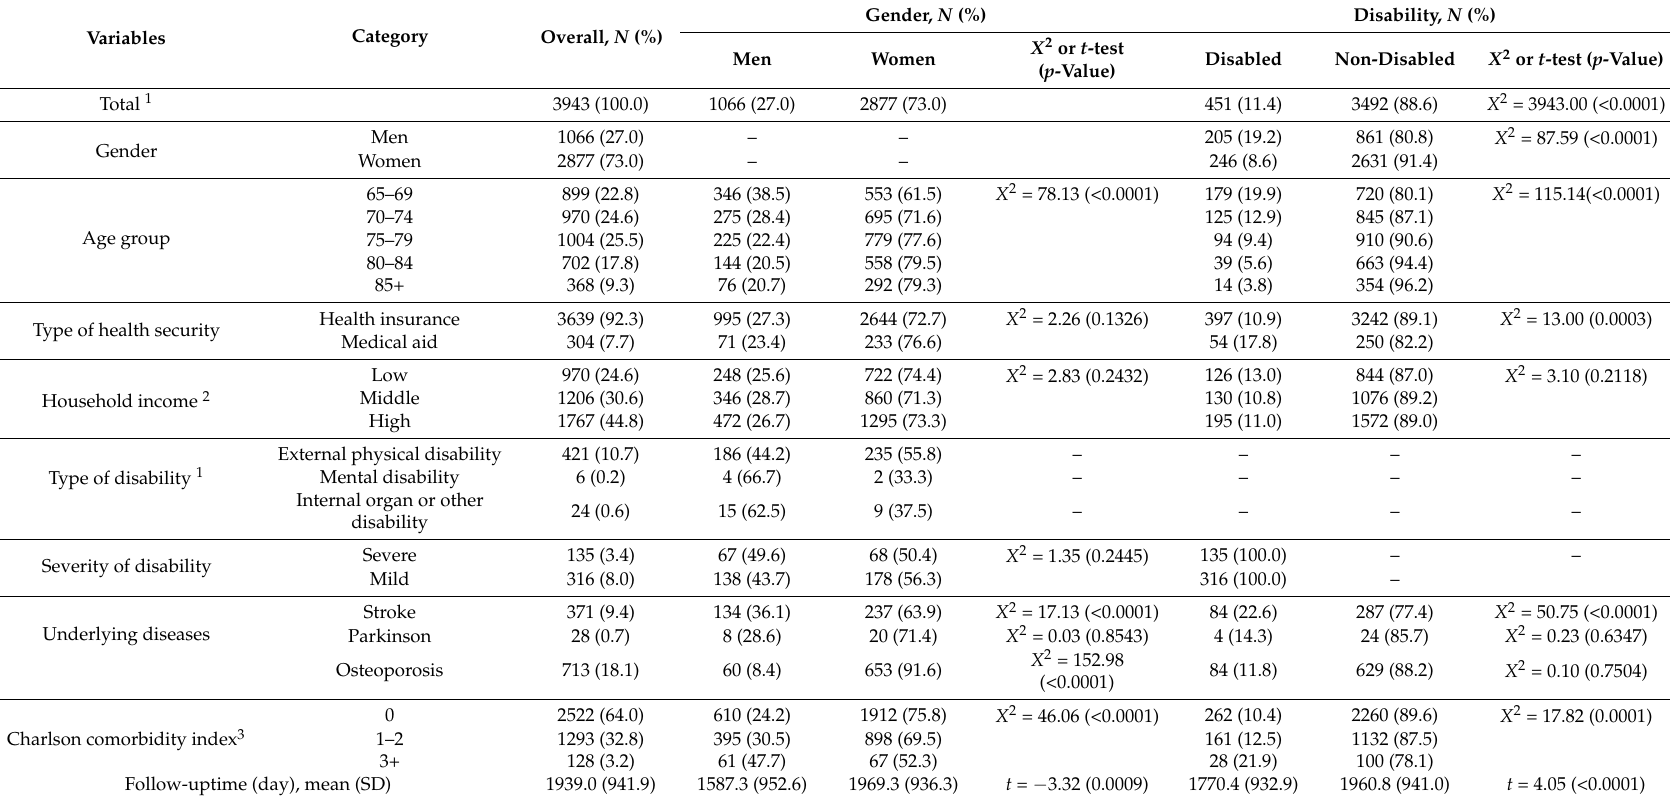
Table 2. General characteristics of older adults who experienced hip